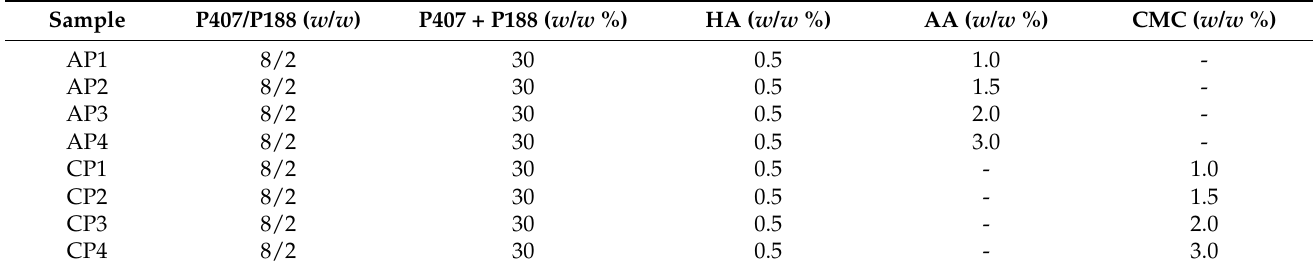
Table 3. Components in the formulation of P407-based hydrogel with different polysaccharides ( w / w % in 10 g